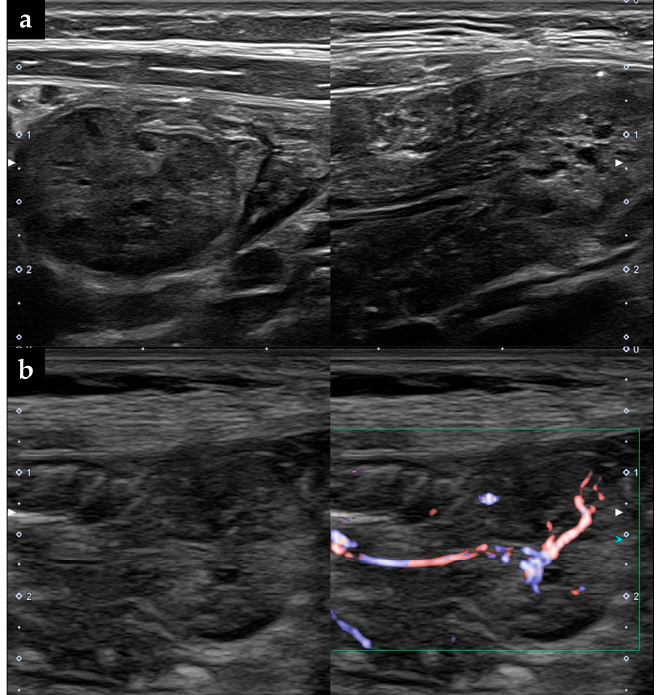
Figure 1. The ultrasonographic findings of the isolated small intestinal polyp. ( a ) Multiple anechoic cysts are identified within the parenchyma of the polyp. ( b ) The pedunculated polyp has a diameter of 15 mm and shows increased internal vascularity.